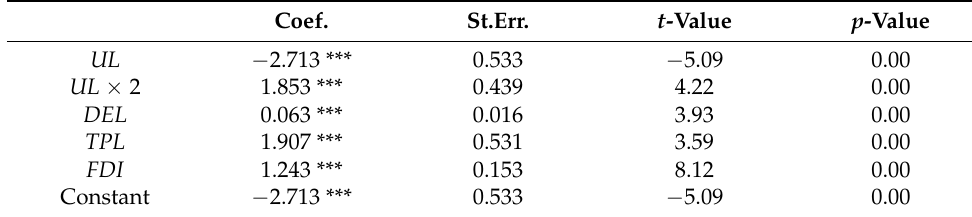
Table 6. The regression results of Tobit